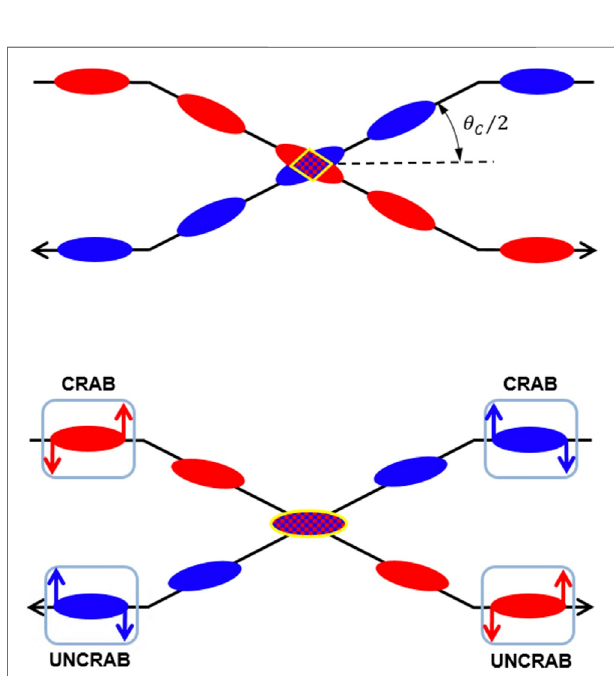
FIGURE 10 | Sketch illustrating crab crossing concept. Top: Beam collision scheme with crossing angle. Bottom: Crab crossing restores full bunch overlapping (Adapted from